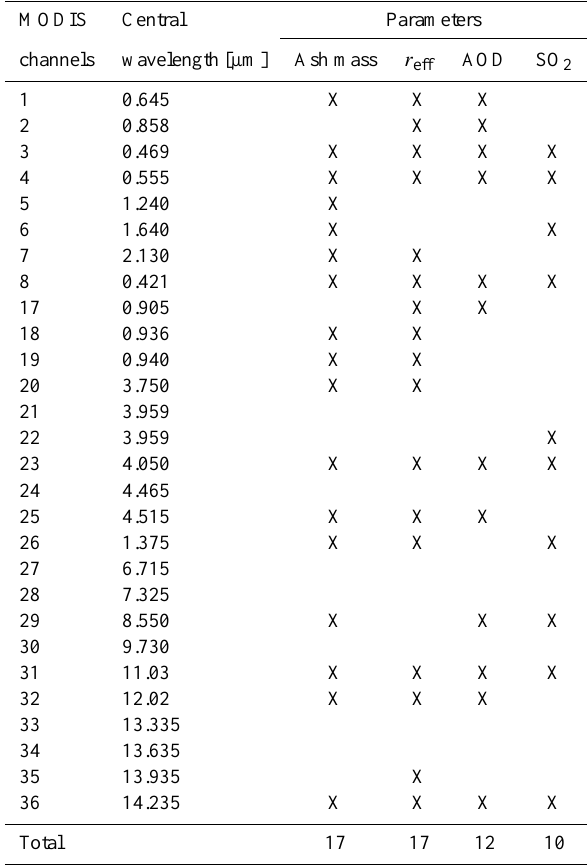
Table 9. MODIS channels selected by the input pruning.